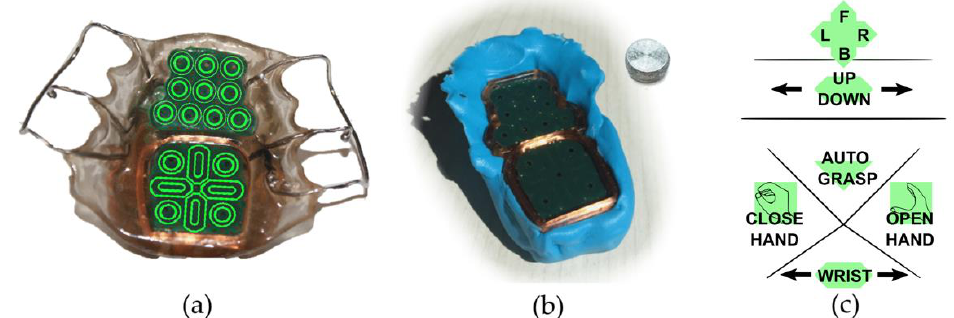
Figure 5. The iTongue tongue interface. ( a ) A standard commercial iTongue mouthpiece with sensor placements superimposed, ( b ) a temporary silicon palate brace as used in the current study together with an activation unit, and finally, ( c ) the control layout developed in this study to control the exoskeleton with shared computer vision based semi-automation. The topmost part acts as a joystick to control the position of the exoskeleton in a horizontal plane, while the up/down slider controls the vertical axis. The wrist supination/pronation is controlled through the bottommost slider. The remaining three icons on the interface act as simple push-and-hold buttons. Note: the text size in the layout has been increased in the figure to increase readability.